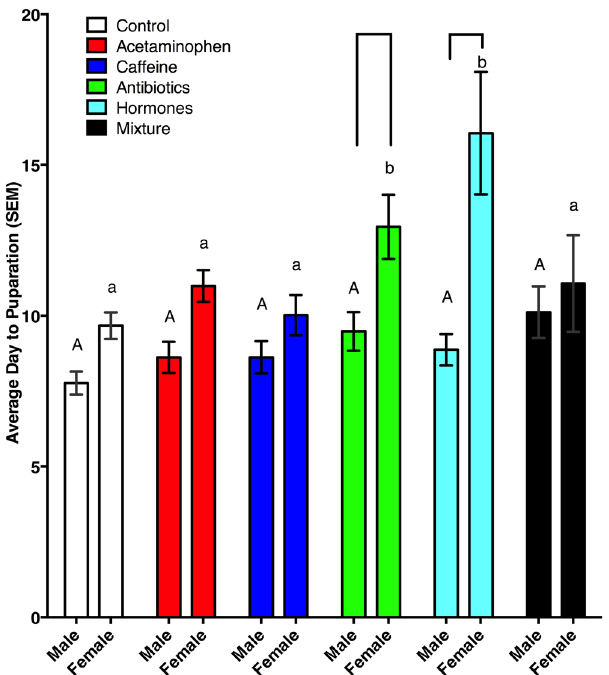
Figure 2. Average day to pupariation of male and female Megaselia scalaris by treatment. Upper case letters denote significant differences in days to pupariation (DTP) from male control. Lower case letters denote significant differences in DTP from female control. *** Denotes an overall day to pupariation difference from